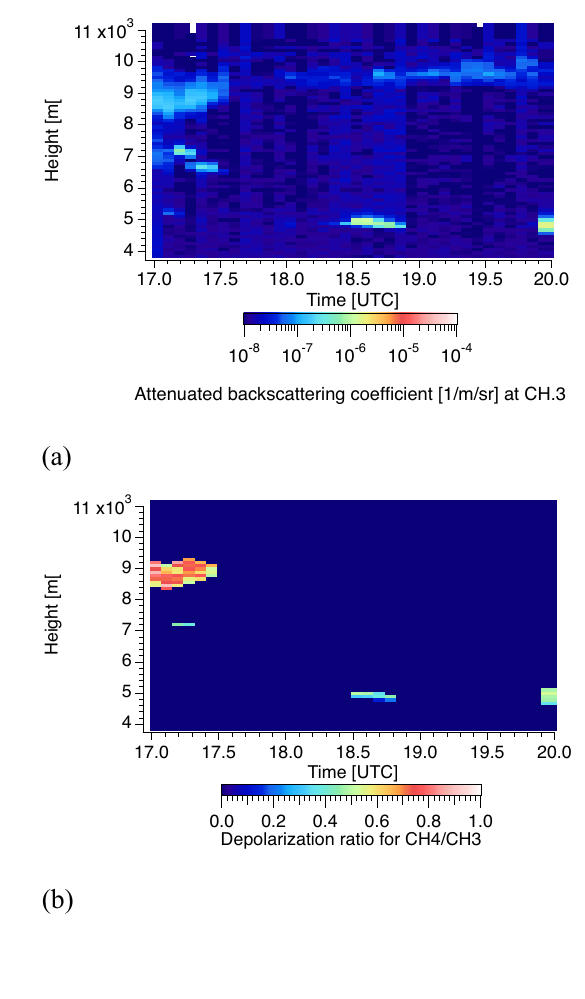
Fig. 1 (a) Time-height cross section of total attenuated backscattering coefficient of clouds and aerosols by on-beam channel, CH.1. Wavelength is 355nm in 23 October 2018. (b) Same as (a) but for depolarization ratio by CH.1 and CH2.